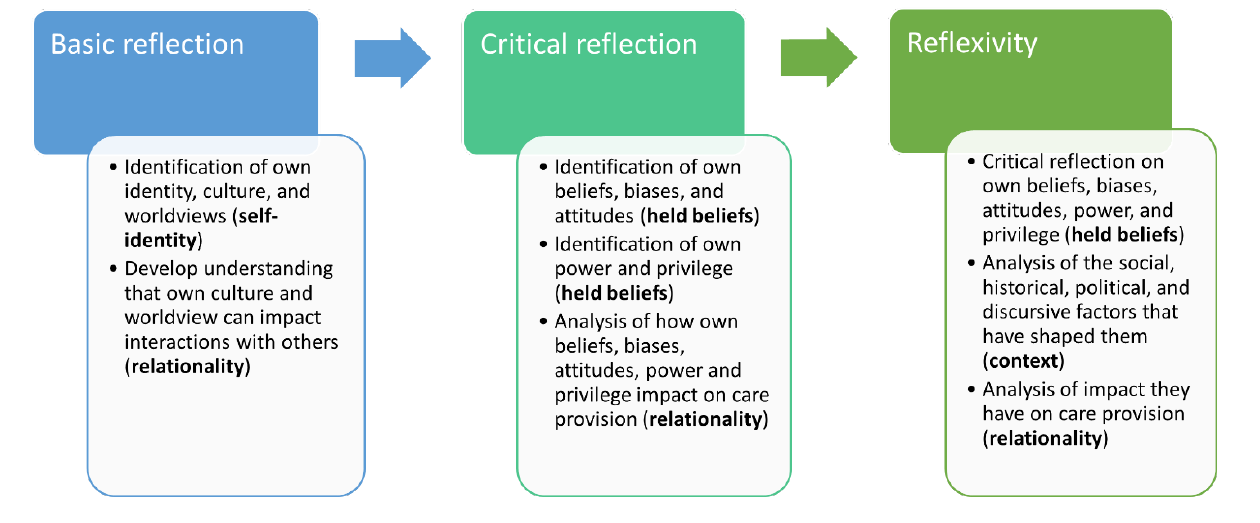
Figure 1. Spectrum of reflexive practice.